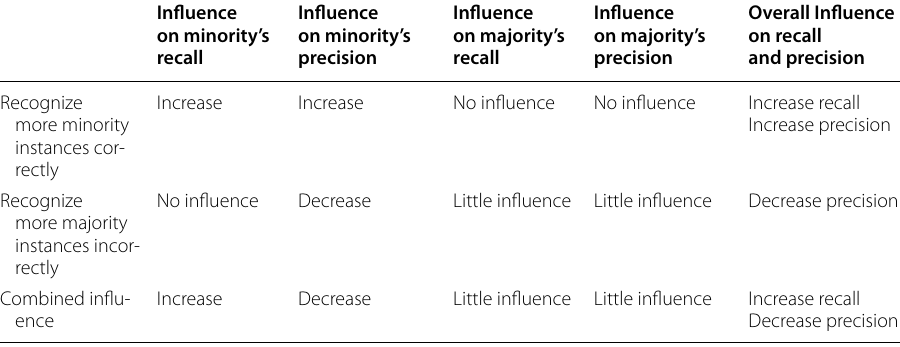
Table 47 Summary for recognizing minority and majority instances on highly imbalanced